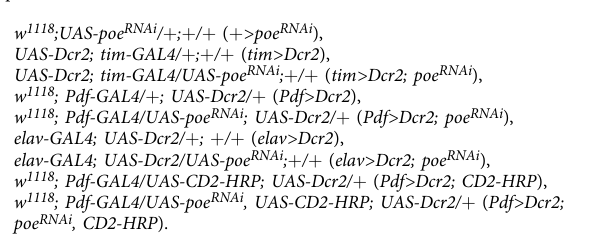
Fig. 6 The absence of UBR4 impairs cargo transport along the secretory pathway and alters Golgi morphology. a NPY-GFP (green) and GM130 (magenta) immuno fl uorescence in UBR4 WT and KO HEK293T cells. DAPI, blue. Pro fi le plots (right) show NPY-GFP and GM130 fl uorescence intensity (F.I.) along the reference axis (white line, merged panel). Scale bar, 5 μ m. b Depiction of how the aspect ratio is calculated. c , d Ratio of NPY-GFP abundance in the cis -Golgi ( c ) or TGN ( d ) relative to the rest of the cell. n = 35 WT, 35 UBR4 KO ( c ), 34 UBR4 KO ( d ). e , f Aspect ratio of cis -Golgi ( e ) or TGN ( f ). n = 39 WT, 41 UBR4 KO; *** p < 0.0001 ( c – f ), two-tailed unpaired t test. g – i Traf fi cking of NPY-GFP (green) in UBR4 WT and KO HEK293T cells using the RUSH assay ( g ). Cells were fi xed at the indicated times post-biotin and CHX addition, and immunostained for NPY-GFP and GM130